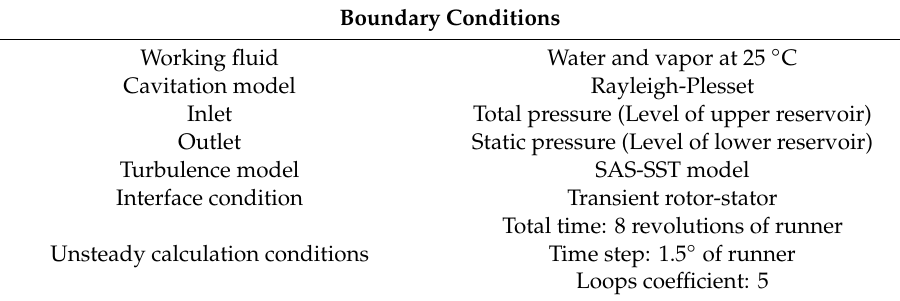
Table 3. Boundary conditions of the Francis turbine